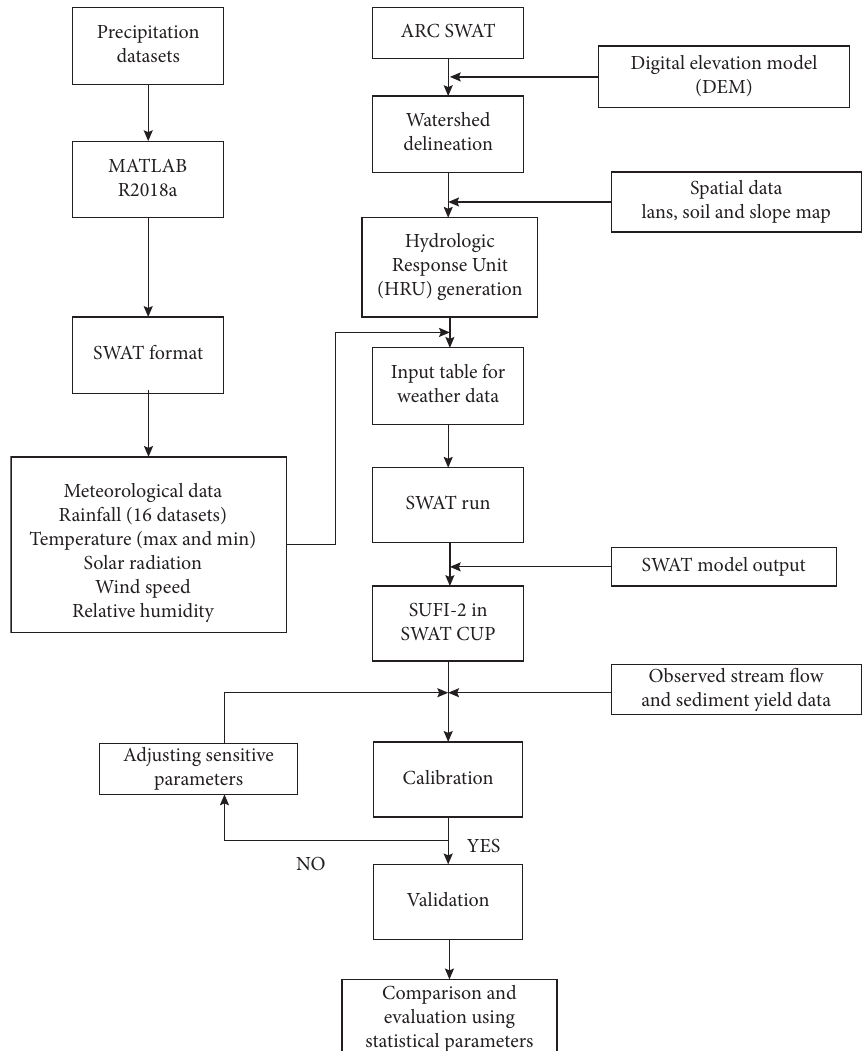
Figure 2: Flowchart of simulating streamflow using the SWAT